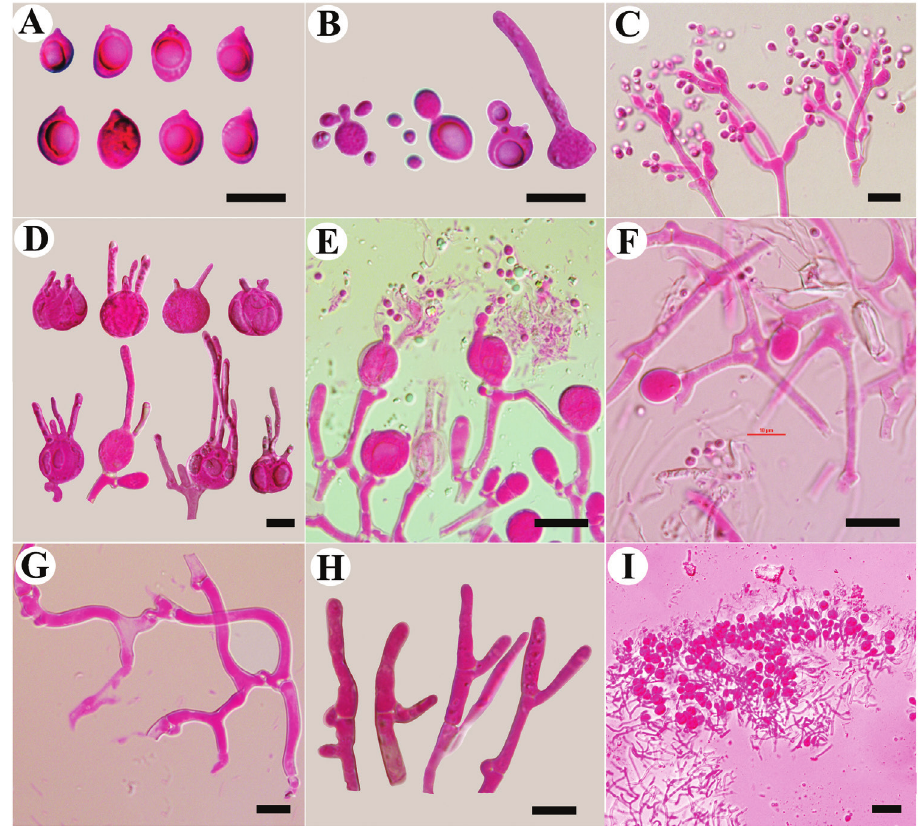
Figure 6. Microscopic structures of Tremella guangxiensis (Wu 3) A basidiospores B germination tubes of basidiospores and secondary spores C conidia and conidiophores D basidia at different stages E, F proba- sidia G hyphae with clamp connections and clamp complexes H hyphidia I a section of hymenium. Scale bars: 10 µm ( A–H ); 20 µm ( I